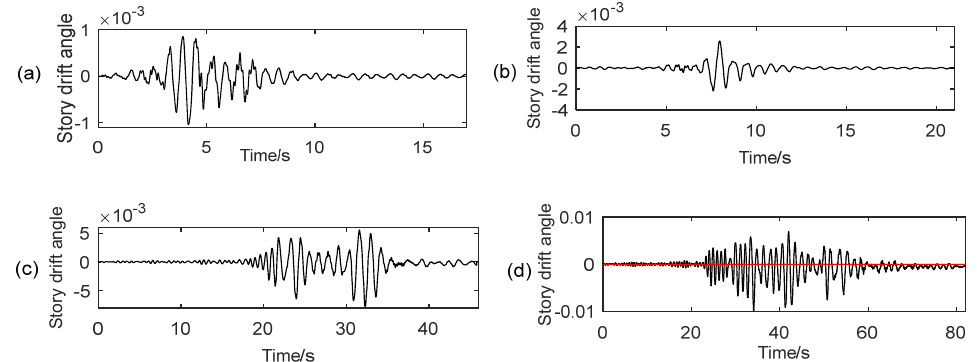
Figure 11. Story drift angle time histories of the bottom story of the frame structure under typical seismic ground motions (rare earthquakes): ( a ) site I group 1; ( b ) site II group 2; ( c ) site III group 3; ( d ) site IV group 3.